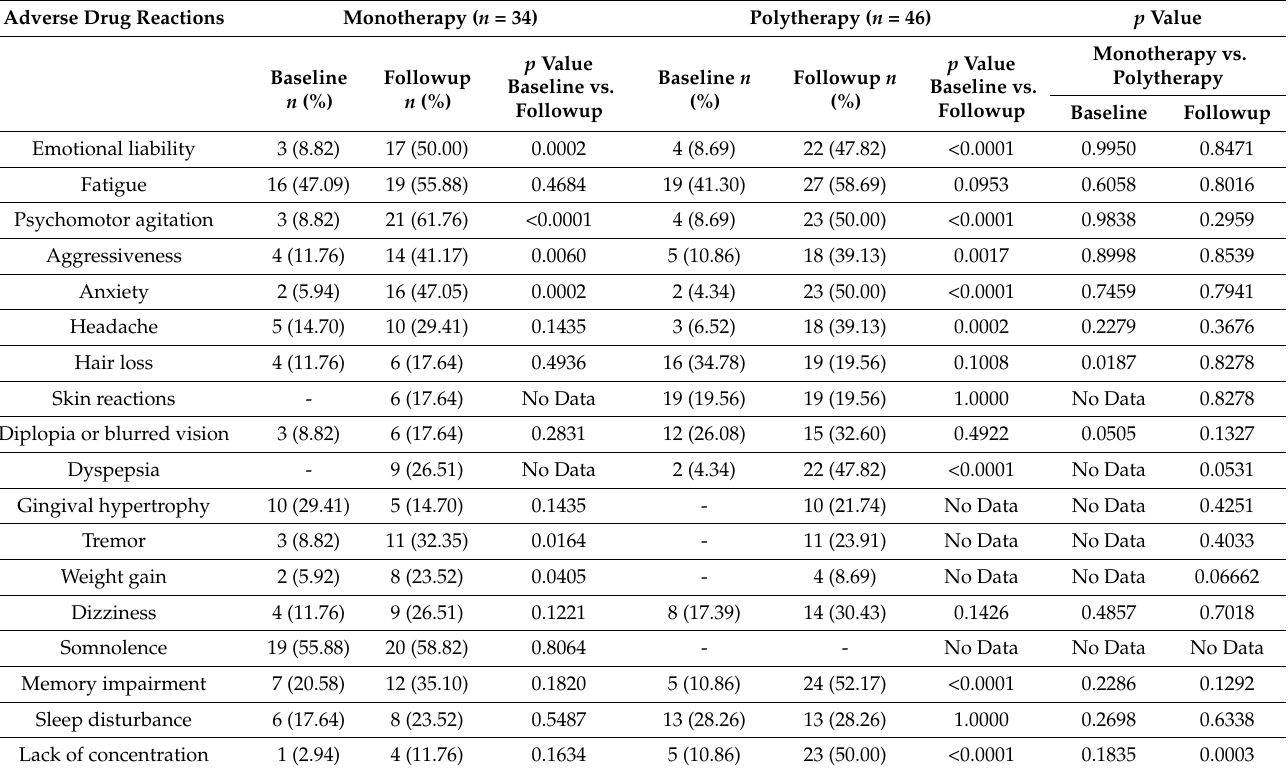
Table 2. Frequency of adverse events in the last three months versus since the beginning of the study according with treatment